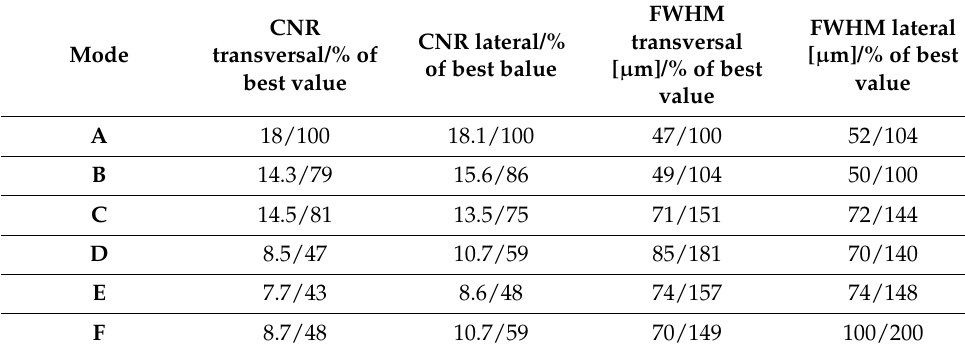
Figure 12. Transversal and lateral central section of the 3D reconstructed volume, Mode F. Table 2. CNR and FWHM of reconstructed tomographic volumes measured on transversal and lateral